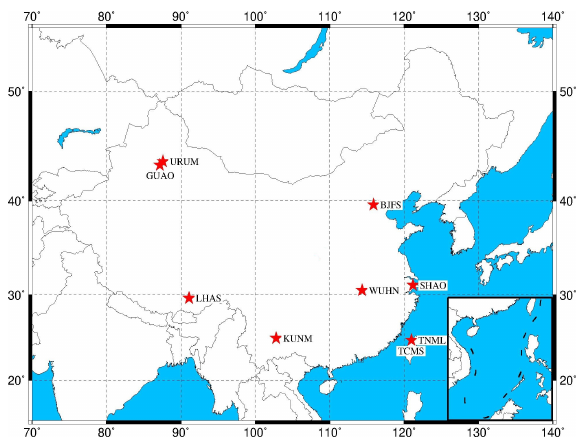
Figure 7. Locations of GNSS sites used in this study, which was prepared using the GMT. Table 5. Locations of GNSS sites used in this